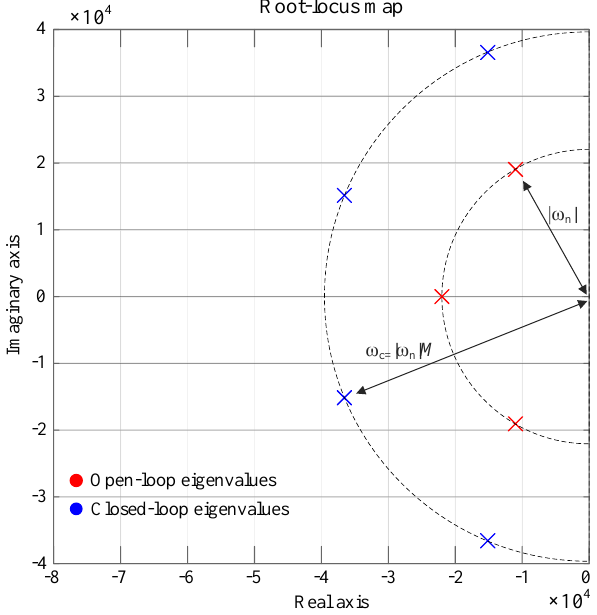
Figure 6. Movement of the root locus in closed loop. Table 3 summarizes ˆA and the closed-loop eigenvalues for each mode. As can be seen, all the eigenvalues have a negative real part and are constrained by the physical frequency boundaries of the system explained before. The control law (21) is used by the three legs of the three-phase full-bridge converter by shifting 120° and 240°, respectively. Table 3. Closed-loop matrices and